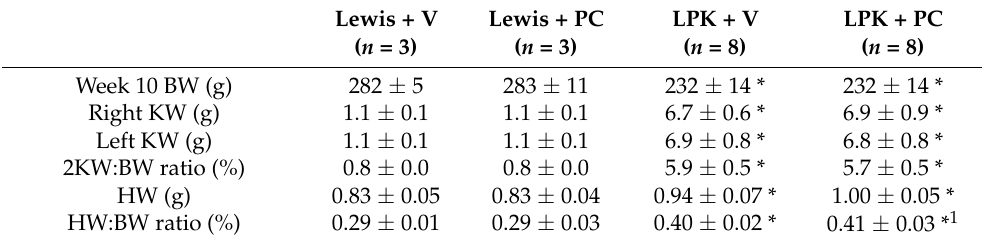
Table 2. Effect of early treatment with paricalcitol on renal and cardiac enlargement at week